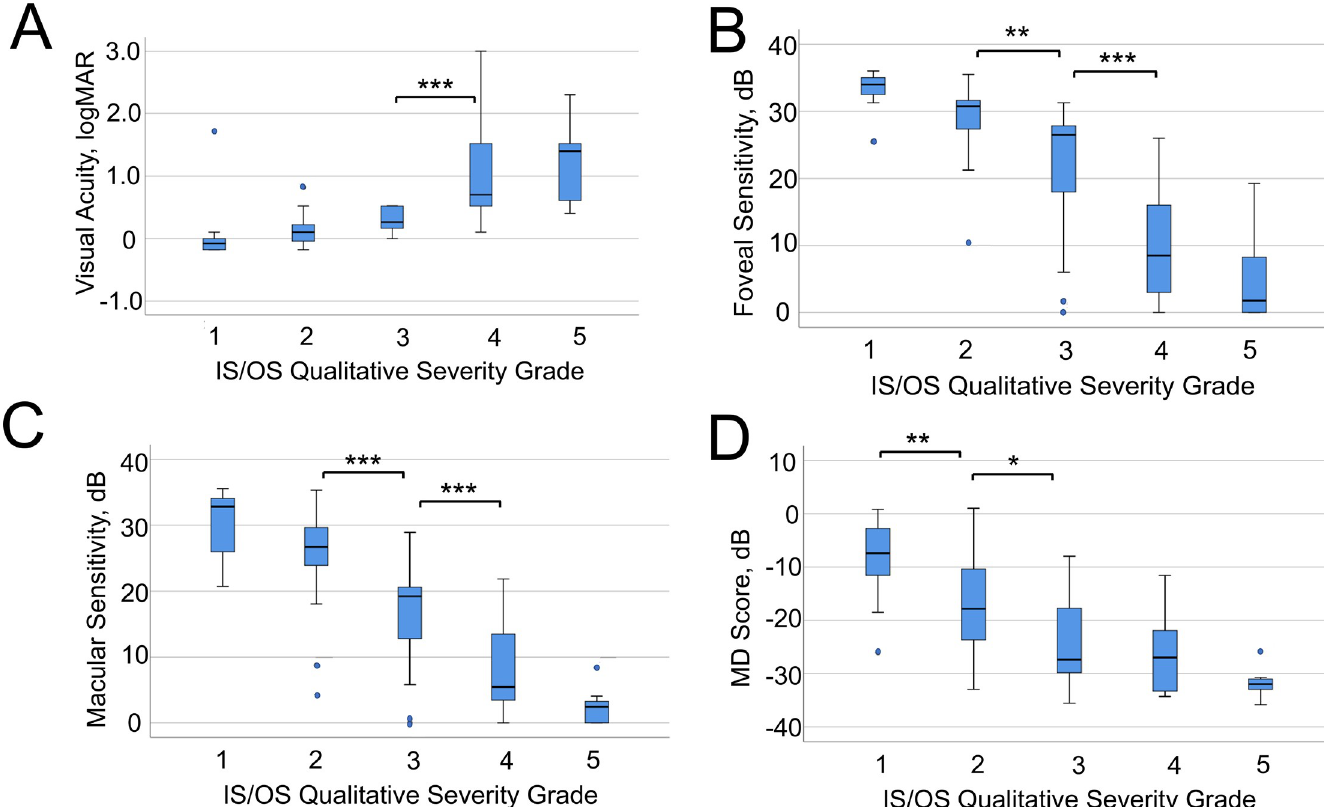
Fig 4. Box plots showing the distributions of values of variables concerning the central visual function in each grade of the qualitative IS/OS severity grade. A, BCVA, B, foveal sensitivity (FS), C, macular sensitivity (MS) and D, mean deviation (MD) of the 10–2 program of the HFA. The median value of each group is shown by the transverse line, and the box indicates the quartile range. Statistical significance; � , P < 0.05; �� . P < 0.01; ��� , P <